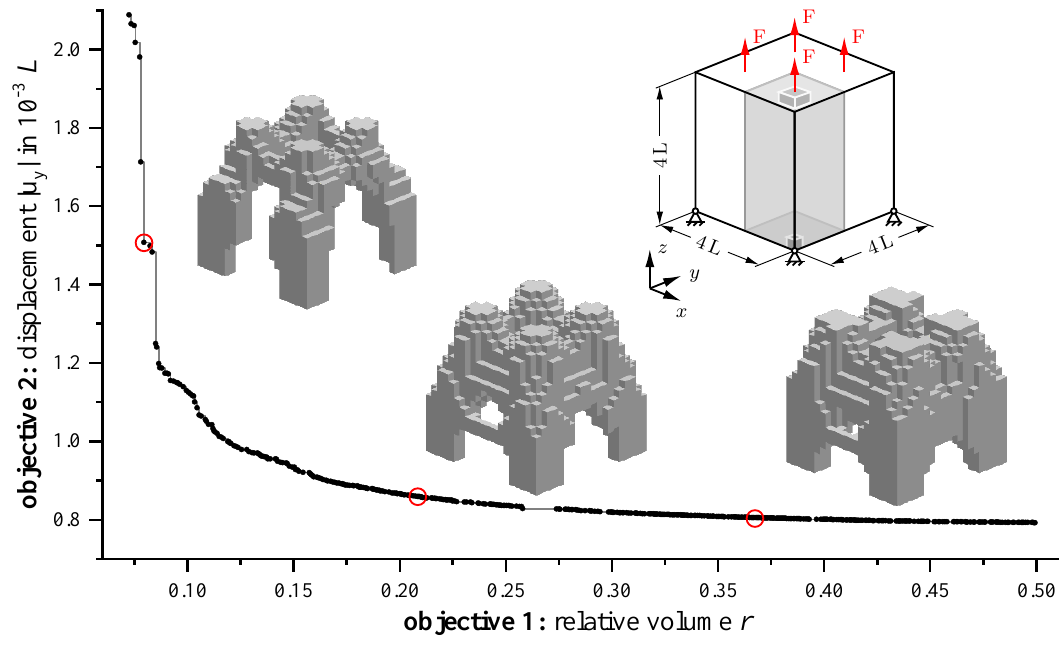
Figure 14. Pareto front with three optimized solutions to a three-dimensional design problem ( top right ) taken from [55]. Symmetries were exploited to reduce the design domain to one fourth of its